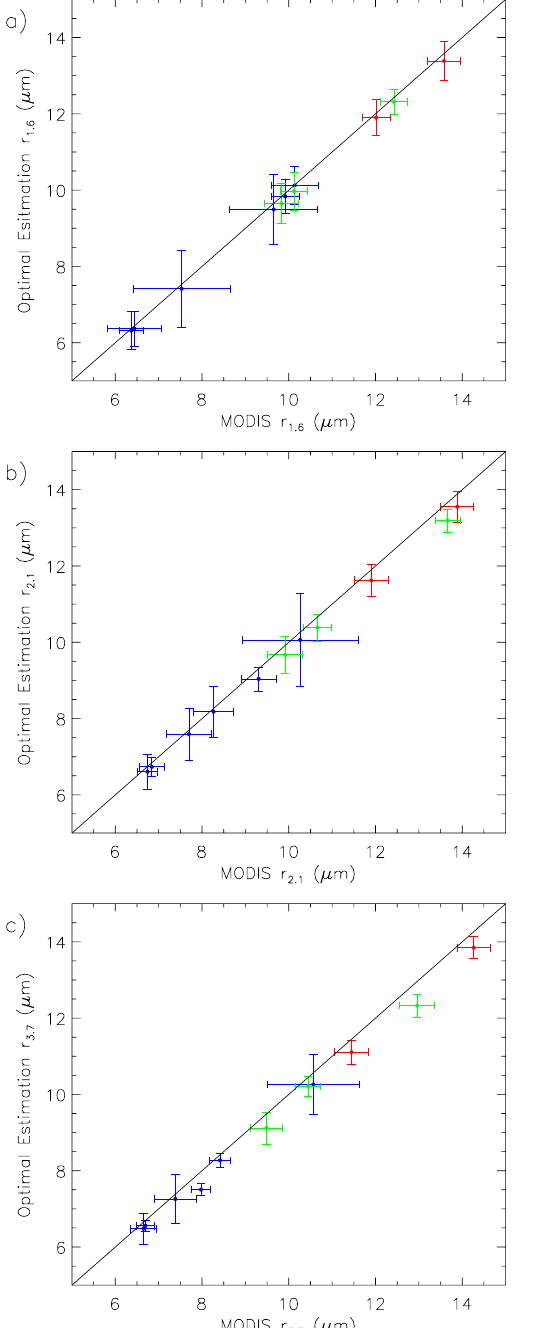
Fig. 12. Comparison between retrievals using an optimal estimation retrieval and the in situ vertically weighted values (dots and solid error bars). The corresponding MODIS retrievals are also shown with crosses and dashed error